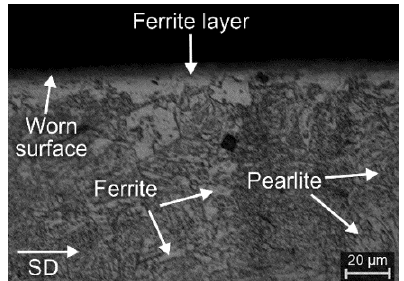
Figure 10. Microstructure of the steel in the cross-section after friction test lubricated with Castor oil at 70 °C.